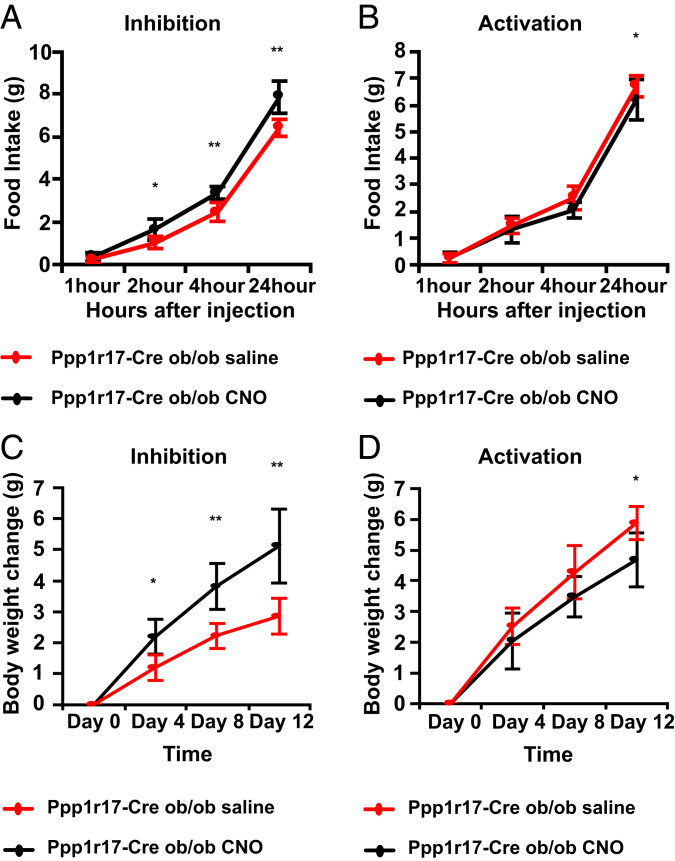
Effect of chemogenetic modulation of DMHPpp1r17 neurons on food intake and body weight in ob/ob mice. (A) Chemogenetic inhibition of DMHPpp1r17 neurons in ob/ob mice. DREADD-induced inhibition of DMHPpp1r17 neurons significantly increases food intake over the course of 24 h. (B) Chemogenetic activation of DMHPpp1r17 neurons in ob/ob mice. DREADD-induced activation of DMHPpp1r17 neurons significantly decreases food intake over the course of 24 h. (C) Body weights of ob/ob mice are significantly increased after chronic inhibition of DMHPpp1r17 neurons by i.p. injection of CNO two times per day. (D) Body weights of ob/ob mice are significantly reduced after chronic activation of DMHPpp1r17 neurons by i.p. injection of CNO two times per day at the end of 12 d (*P < 0.05, **P < 0.01, ***P < 0.001, ****P < 0.0001, two-tailed unpaired t test; n = 5 mice). All error bars are mean ± SD.